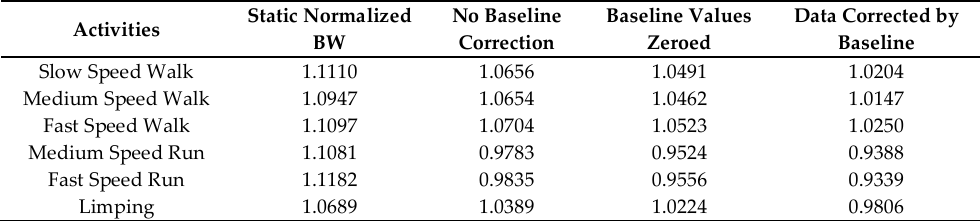
Figure 2. ( a ) Forces measured during fast running and ( b ) forces measured during medium speed walking. Table 1. Calculated BWs normalized to the actual BW for different correction